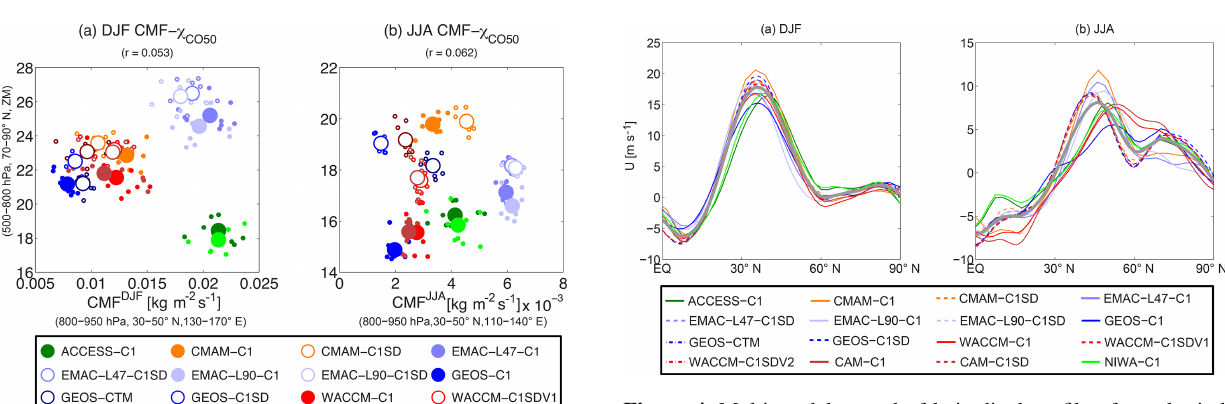
Figure 4. Multi-model spread of latitudinal profile of zonal wind u vertically averaged between 500 and 800hPa and longitudinally averaged over the Pacific Ocean (135 ◦ E–135 ◦ W) during (a) DJF and (b) JJA. C1 simulations are shown as solid lines while C1SD simulations are shown as either dashed or dotted–dashed lines. The corresponding ensemble means are depicted as the heavy gray